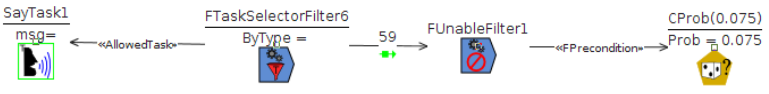
Figure 8. Filter applied to the speaking